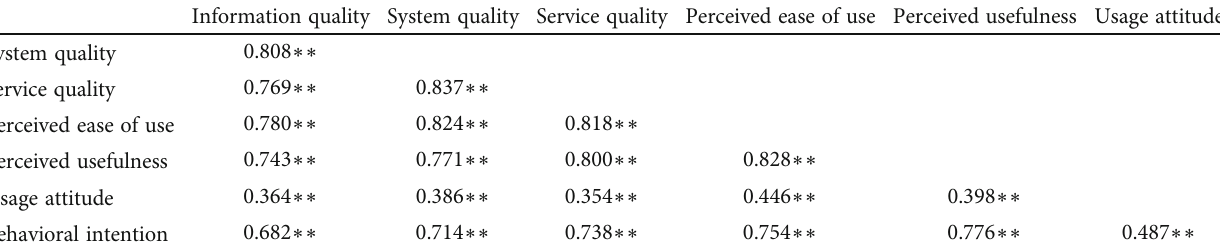
Table 3: Correlation coe ffi cient of